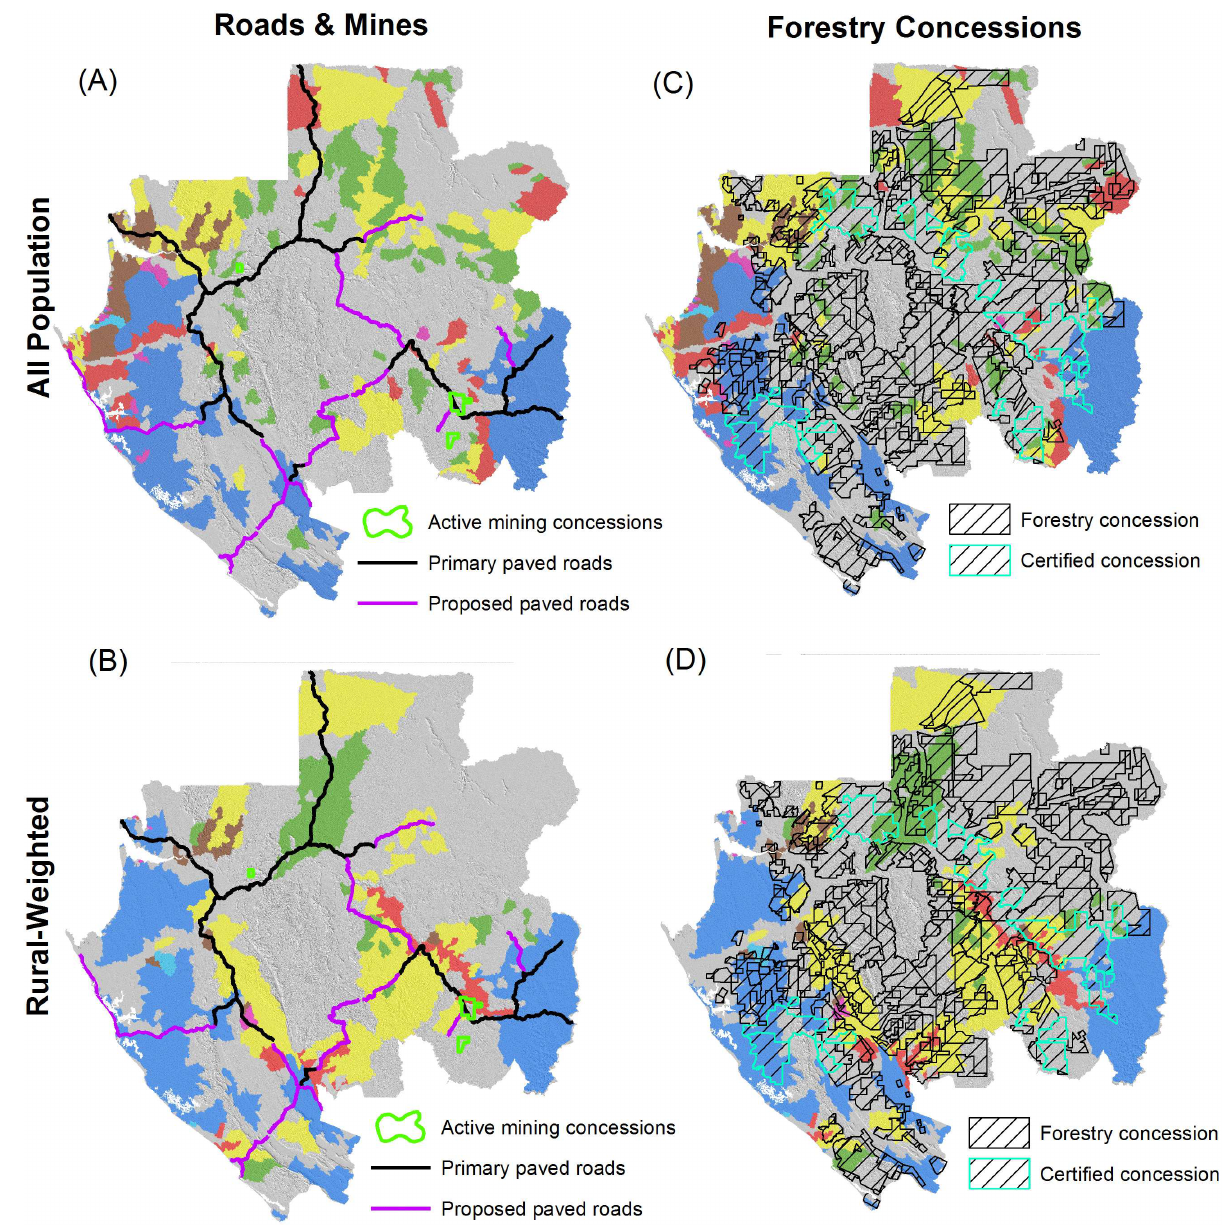
Fig 7. Overlap of hydrologic ecosystemservicespriority areas with indicators of economic development activities. (A) “All population”scenariowith active miningconcessionsand roads. (B) “Rural-weighted” scenario with active mining concessions and roads. (C) “All population”scenario with forestry concessions. (D) “Rural-weighted” scenario with forestry